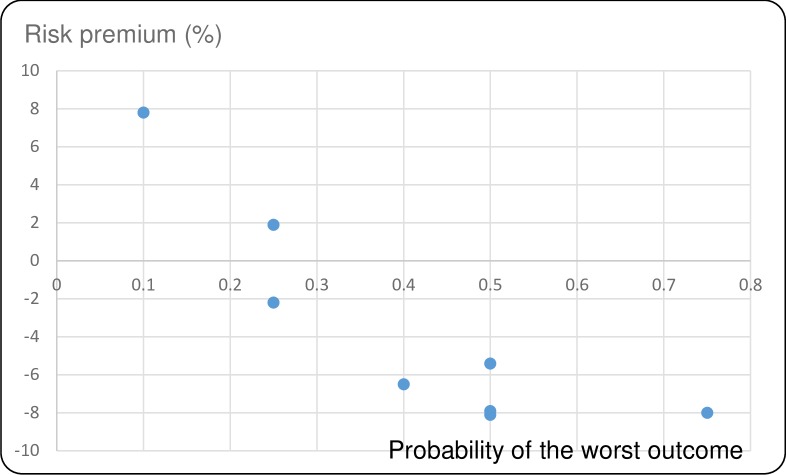
Risk premiums plotted against probability of the worst outcome in the losses lottery for FPR.